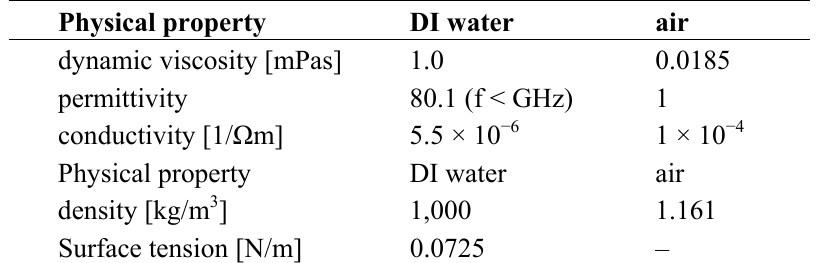
Table 1. Material properties of the fluids used for the presented simulations.